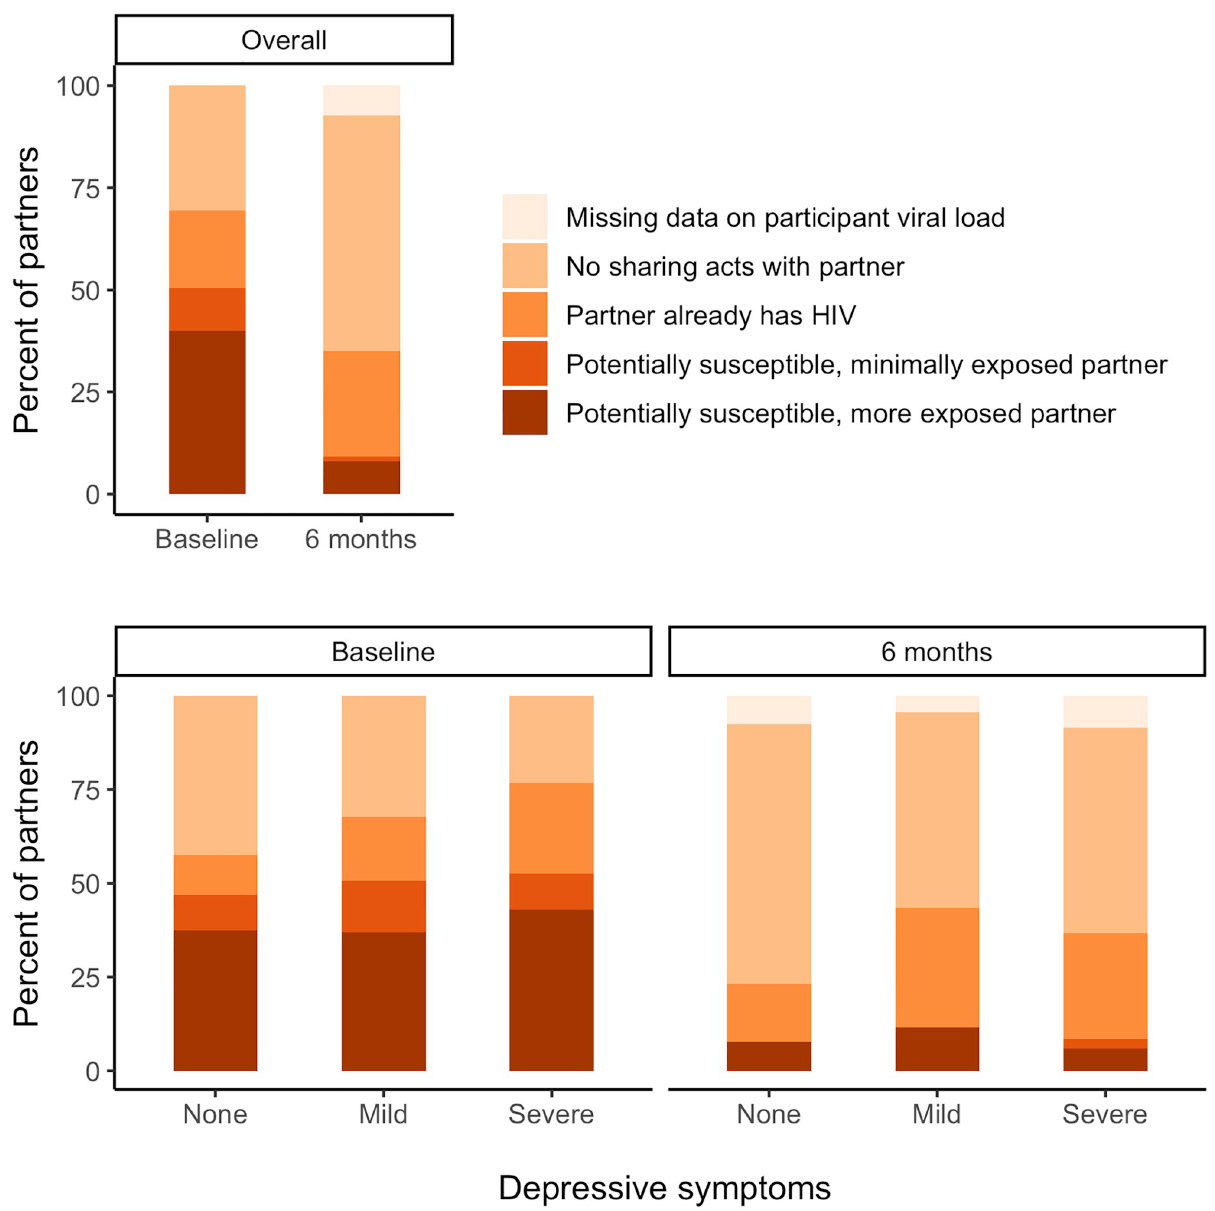
Fig 1. Distribution of partner susceptibility and exposure to HIV, overall and by participant’s baseline depressive symptoms. Percentages are based on the 833 partners reported by 455 participants at the baseline visit and the 251 partners reported by 377 participants at the 6-month visit. “Potentially susceptible” refers to partners with reported HIV-negative or unknown HIV status. Among potentially susceptible partners, “minimally exposed” had � 1 sharing act with a participant who had suppressed viral load ( < 400 copies/ml). “More exposed” partners participated in � 1 sharing act with a participant who had unsuppressed viral load ( � 400